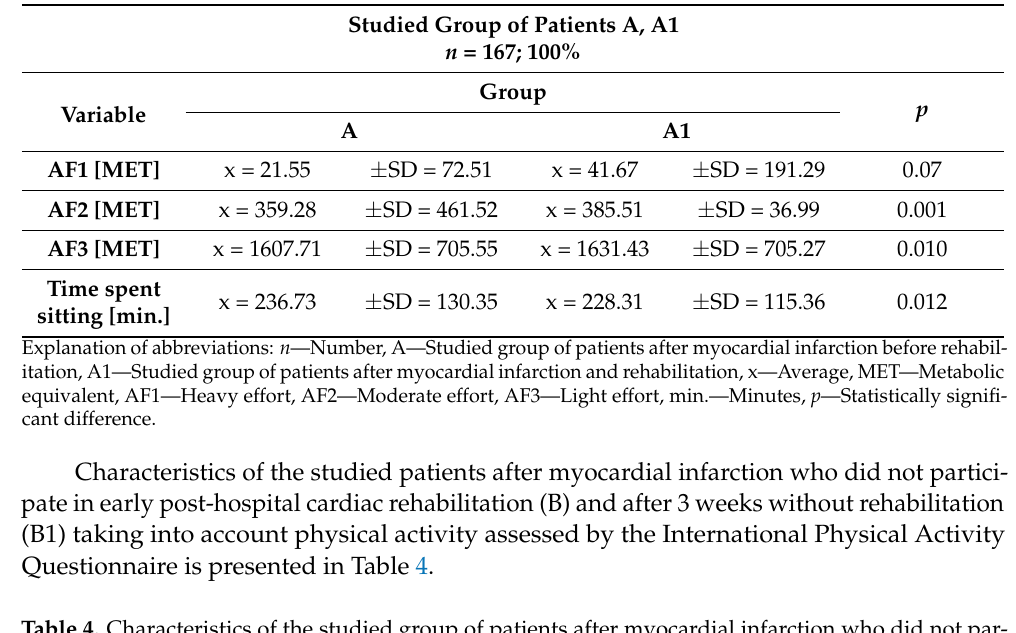
Table 3. Characteristics of the studied group of patients after myocardial infarction before (A) and after early post-hospital cardiac rehabilitation (A1), including physical activity assessed by the International Physical Activity Questionnaire.